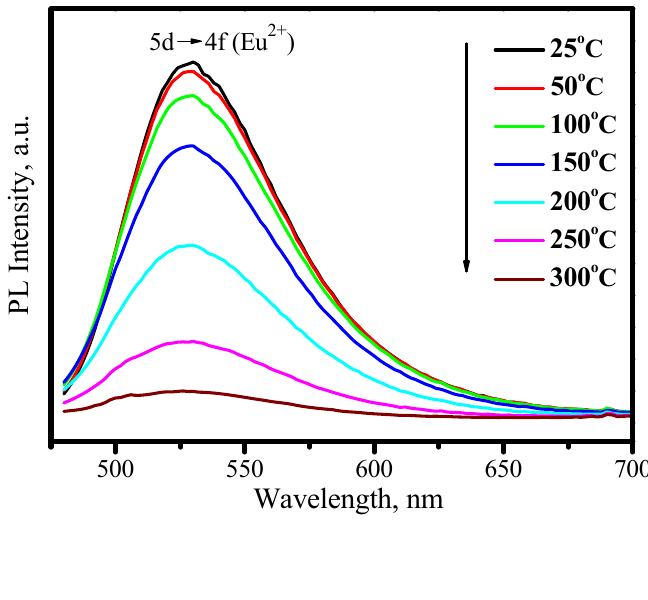
Figure 14. Emission spectra of (Ba different